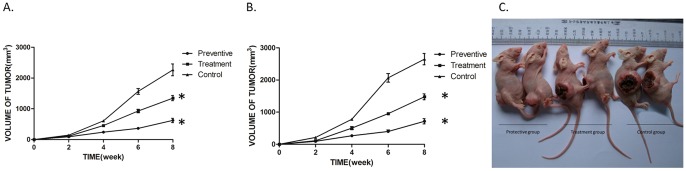
Anti-tumor efficacy of I3C in nude mice.The effect of I3C on tumor growth of 5-8F(A) and CNE2(B) in xenograft nude mice. The data are presented as the mean± SEM. *p<0.05, compared to control group.